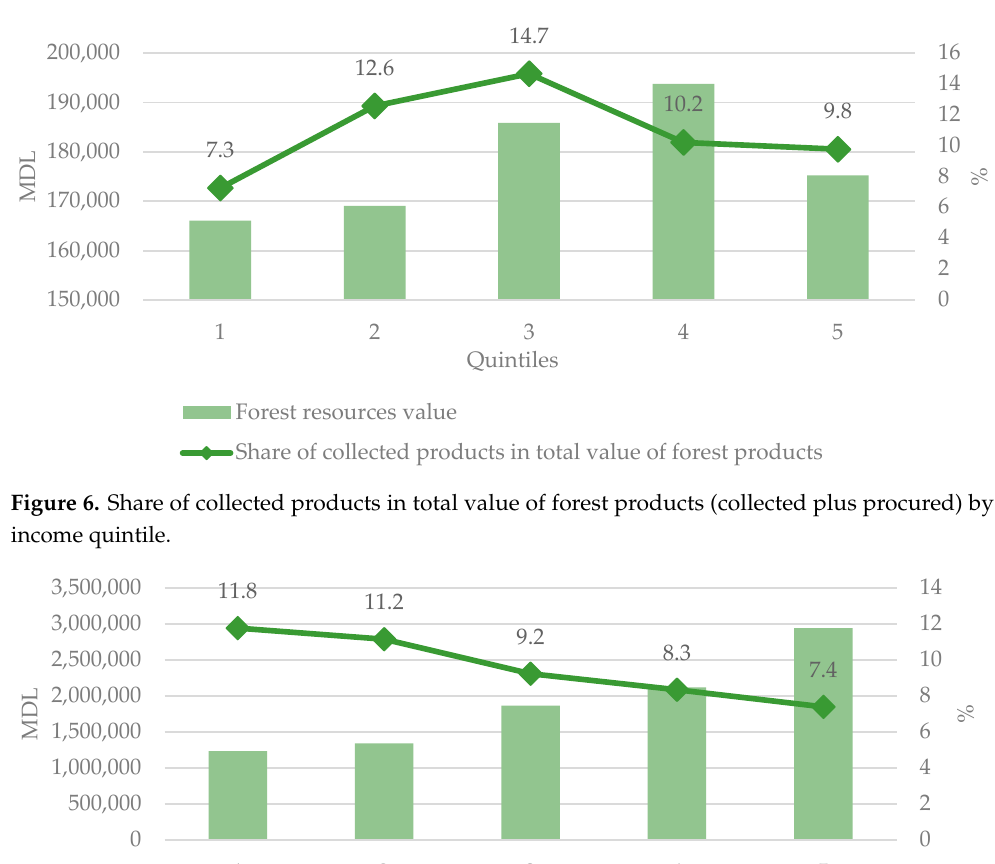
Figure 6. Share of collected products in total value of forest products (collected plus procured) by income quintile.